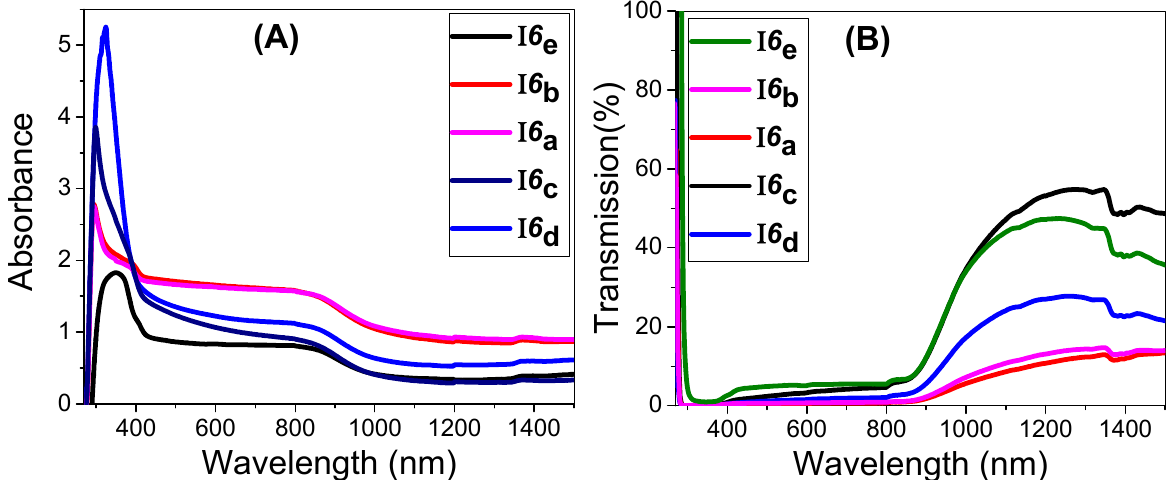
Figure 10. ( A ) Absorbance and ( B ) transmittance spectra for the present series I6 a–e at 115 °C. The relationship between the absorption coefficient ( α ) and photon energy ( hv ) for the direct allowed transitions is defined by the optical absorption theorem (Equation (3)) [65]: